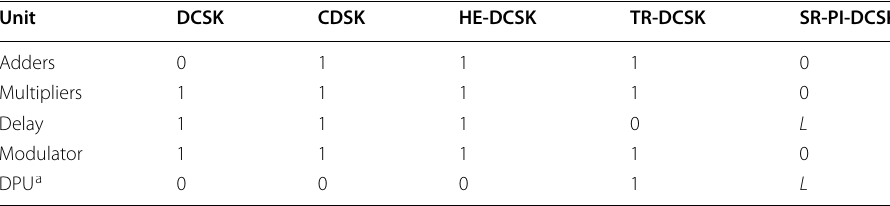
Table 2 Transmitter system complexity analysis (for one information bits) Unit DCSK CDSK HE-DCSK TR-DCSK Adders Multipliers 1